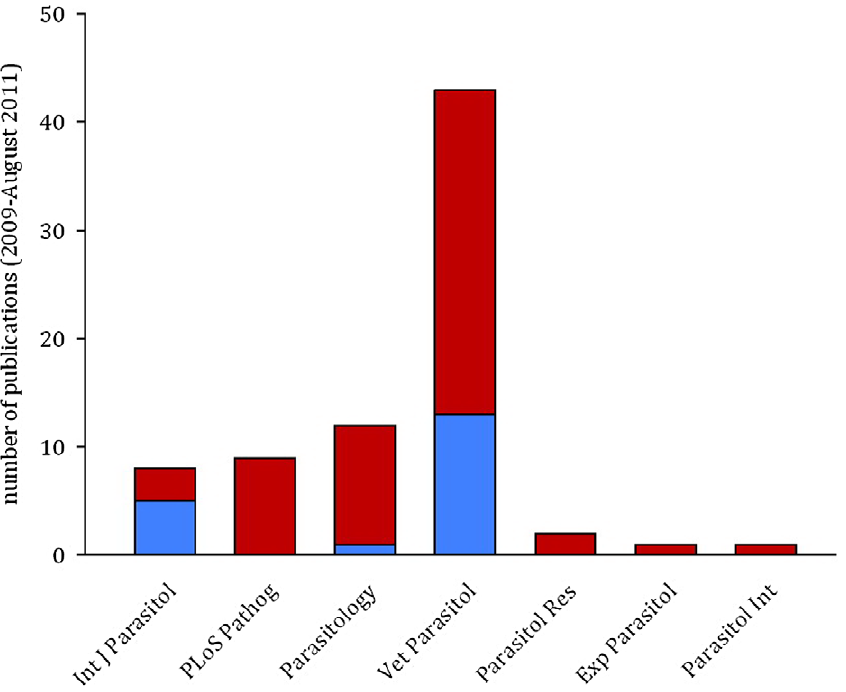
Figure 3. The majority of publications in parasitology do not control for temporal auto-correlation. Bars show the result of a literature search for papers using mixed effects models to analyse time-course data sets in seven parasitology journals from January 2009 to August 2011. Of 76 papers examined, 19 explicitly controlled for temporal auto-correlation (blue), but no controls were mentioned in 56 (red).